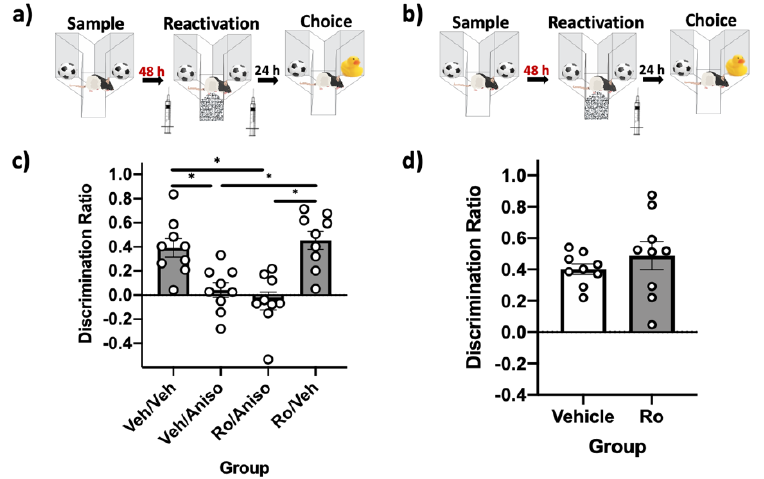
Figure 4. GluN2B-containing NMDARs in PRh are not involved in destabilizing or reconsolidating remote (48h) object memories. ( a ) Remote SOR parameters, where contextual novelty in the form of a floor insert is required at the time of reactivation to destabilize remote object memories. PRh infusions were performed immediately prior to reactivation to target destabilization and prevent the impairing effects of post-reactivation infusion of anisomycin. ( b ) Remote SOR parameters, where only post-reactivation PRh infusions were performed to target reconsolidation. ( c ) Choice-phase DRs. The veh–veh and Ro–veh groups had choice DRs that differed from their respective sample DRs, suggesting that these groups had intact memory. Memory in both groups receiving post-reactivation anisomycin was significantly impaired compared to vehicle conditions. ( d ) Choice-phase DRs, demonstrating no differences in memory performance. Both groups’ choice DRs differed significantly from their respective sample DRs, suggesting memory was intact. Bars are mean DR ± SEM; * p < 0.05.